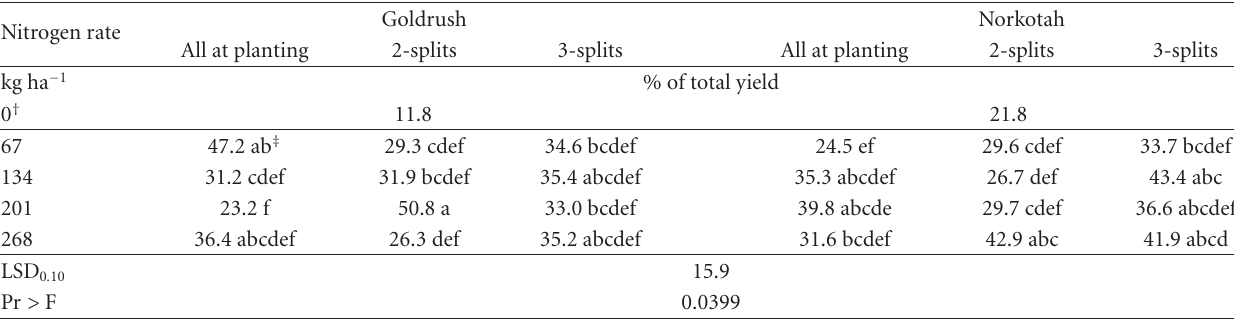
Table 4: Nitrogen rate × N application timing × variety interaction in 2009 for rotten tubers as a percentage of total yield for Russet potatoes grown on sandy loam soils in the Mid-Atlantic.